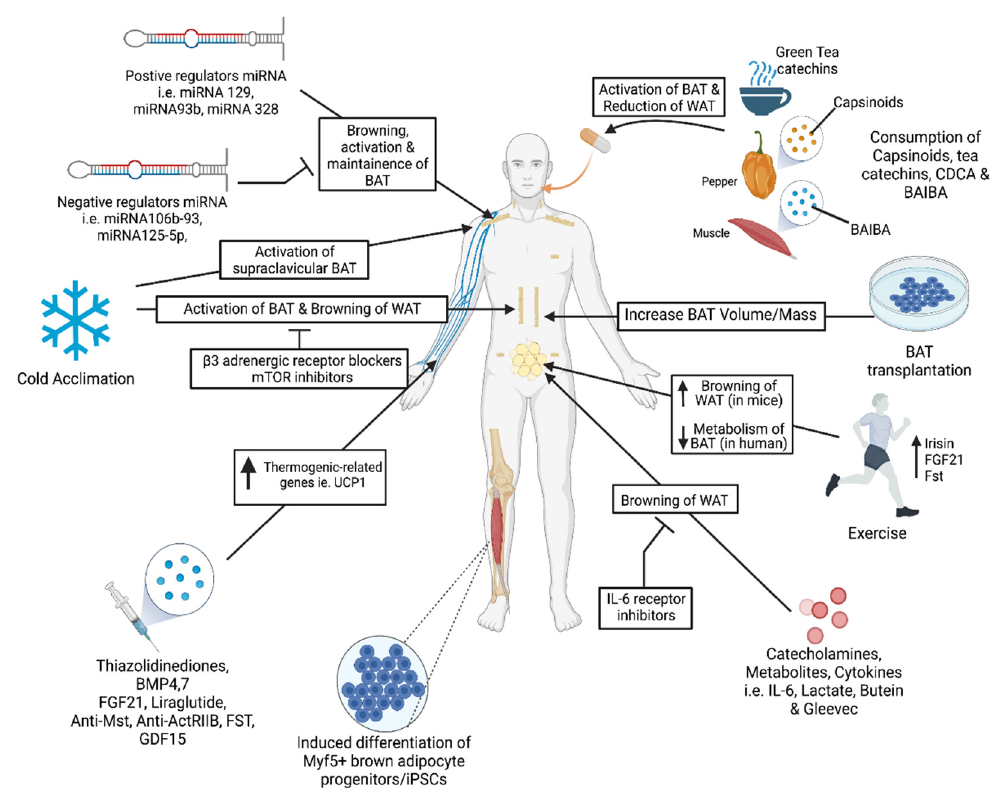
Figure 2. Therapeutic interventions to increase BAT mass and activity. Acute or chronic cold exposure activates BAT metabolism or induces BAT browning. β 3-AR blockers and mTOR inhibitors inhibit the browning of WAT and the activation of BAT. Exercise activates BAT and induces WAT browning via the upregulation of irisin, follistatin (Fst) and FGF21 (fibroblast growth factor 21). Intravenous (IV) administration of proteins, i.e., FGF21, growth and differentiation factor 15 (GDF15), bone morphogenic protein 7 (BMP7) and follistatin (FST), or anti-Activin receptor type 2B (ActRIIB), anti-Myostatin (Mst) antibodies and various pharmaceutical agents, including Liraglutide and thiazolidinediones, upregulate thermogenic genes like UCP1 to induce the browning of WAT. WAT browning is also induced through the use of Gleevec, lactate and Butein. Certain cytokines, catecholamines and metabolites were used for the browning of WAT. IL-6 receptor inhibitors block the browning of WAT. BAT transplantation increases BAT mass and activity. MiRNAs target regulatory mechanisms that regulate thermogenesis and the browning of WAT either positively or negatively. Trans-differentiation of induced pluripotent stem cells and mesenchymal progenitor cells into brown adipocytes by targeting regulatory mechanisms to overexpress thermogenic and adipogenic genes. Diet or consumption of oral supplements known to activate BAT, like capsinoids, tea catechin and BAIBA can be extracted and utilized as an IV injection or as an oral supplement.